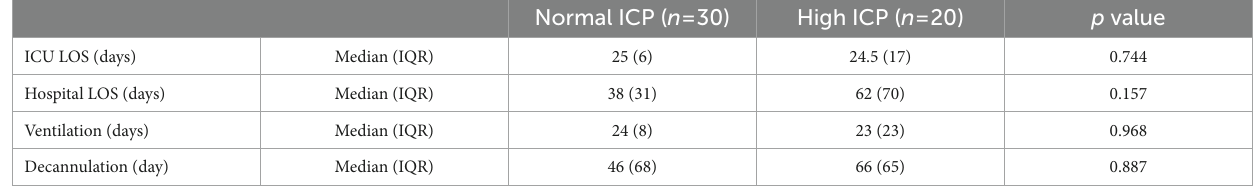
TABLE 4 ICU and hospital length of stay, duration of mechanical ventilation, and days on tracheostomy stratified to normal versus high ICP status.